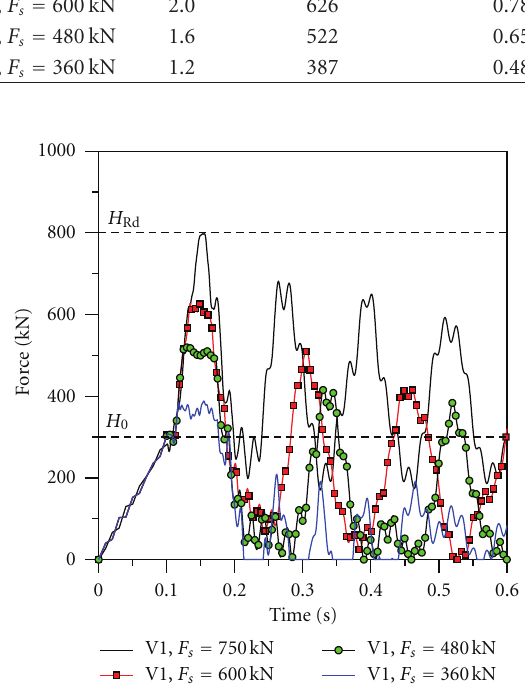
Figure 17: Comparison of axial force in the cables, as a function of time (ABAQUS). Single vertical device. M02 FE-model, BL1.